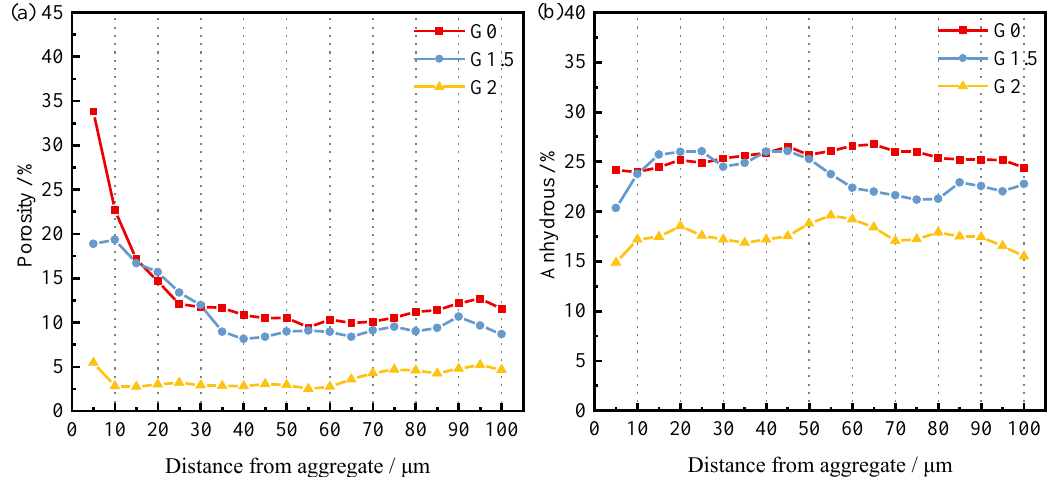
Figure 12. Effect of IOT grinding time on ( a ) Porosity, and ( b ) Anhydrous profiles of 28-d concrete.